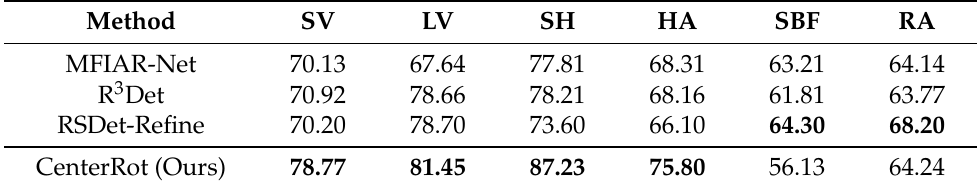
Table 4. Comparison of selected categories in DOTA. All methods use ResNet152 as a